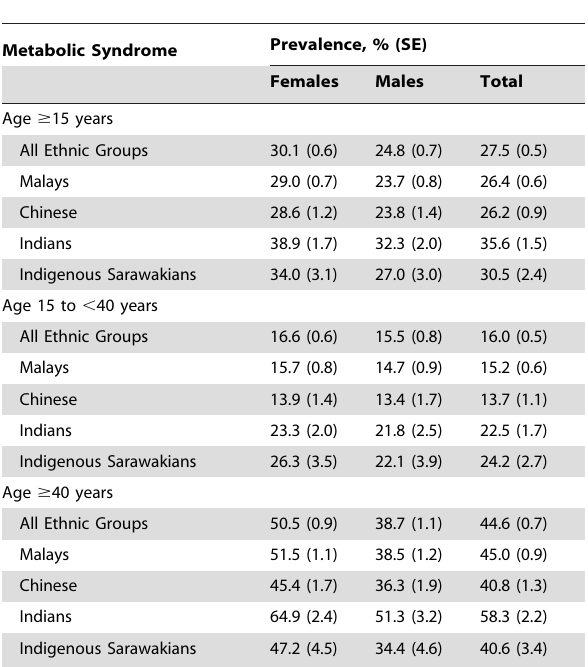
Table 2. Prevalence of metabolic syndrome by gender among Malaysians $ 15 years, 2004.